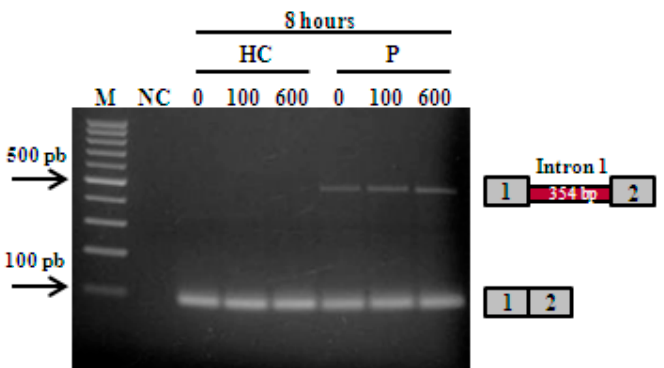
Figure 1. Transcriptional profile obtained after reverse transcription (RT)-PCR amplification of RNA extracted from healthy control (HC) and patient (P) fibroblasts, untreated and treated with two different concentrations of cycloheximide (100 and 600 µg/mL) for 8 h. Agarose gel electrophoresis showed one band for control fibroblasts and two for patient. The patient pattern revealed an upper band (451 bp) corresponding to an aberrant spliced transcript with the insertion of 354 bp of intron 1 (between exons 1 and 2), and a lower weight band (87 bp) for a transcript with exons 1 and 2, with the synonymous nucleotide change c.66G>A in the last base of exon 1. The control profile showed only a correct spliced product composed of exons 1 and 2. M—molecular marker; NC—negative control; HC—healthy control; P—patient.